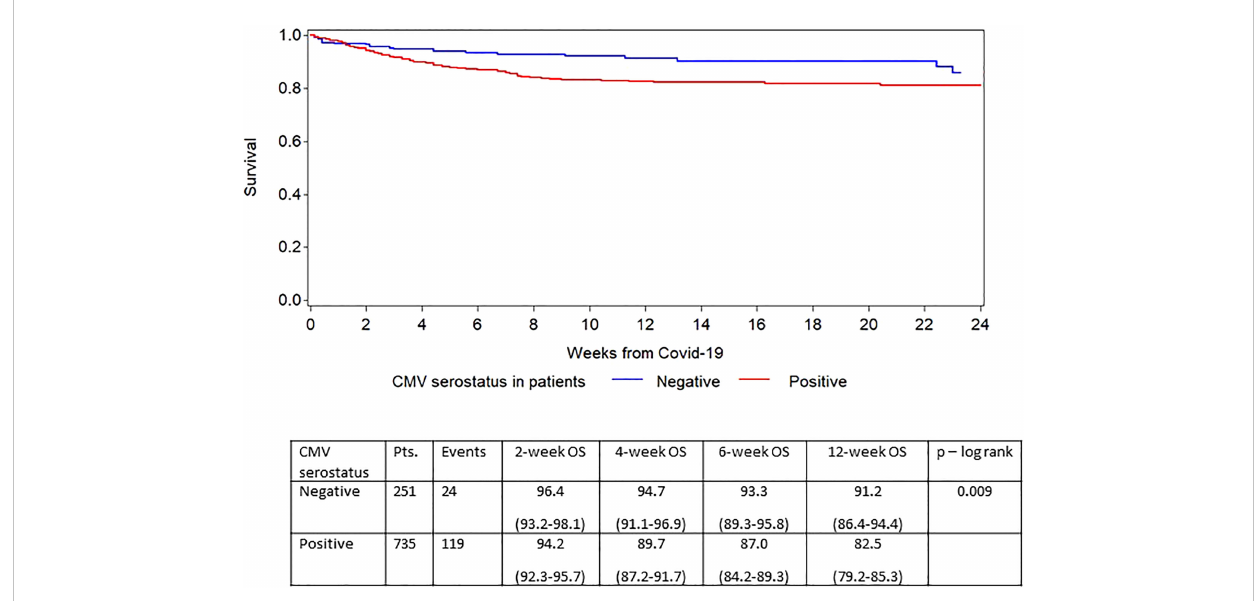
FIGURE 5 Survival based on recipient CMV serostatus.